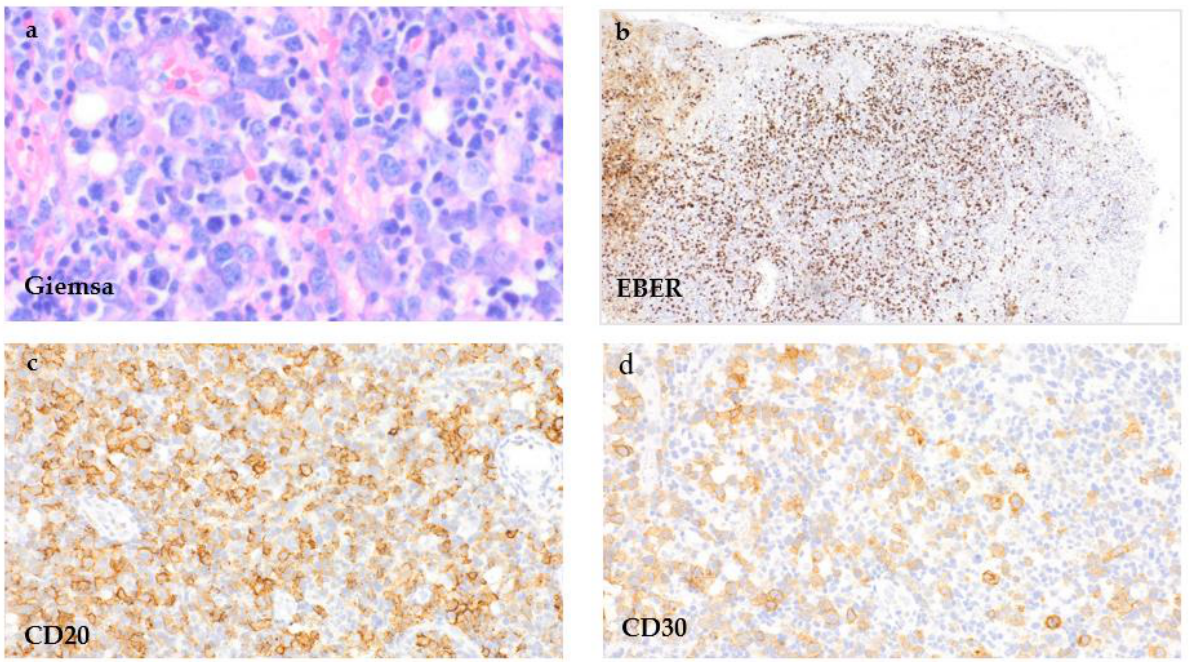
Figure 3. EBV-MCU of the hypopharynx. Tissue samples of the hypopharyngeal ulcer taken directly below the epithelial ulceration by incisional biopsy, showing a polymorphous cell infiltrate with HRS-like cells in an inflammatory background (( a ), Giemsa stain, 400 × ) that show positivity in the EBER in situ-hybridization (( b ), EBER, 100 × ) and for CD20 (( c ), 400 × ) and CD30 (( d ), 400 × ). The tissue sample of the lower lip presented a superficial ulcer with a subepithelial polymorphous cell infiltration dominated by small lymphatic B cells and plasma cells. EBV activation in the EBER in situ hybridization could be proven as well. In contrast to the specimen of the hypopharyngeal ulcer, there was no elevated proliferation rate or clear increase in CD30-positive cells. A co-expression of CD23 was slightly